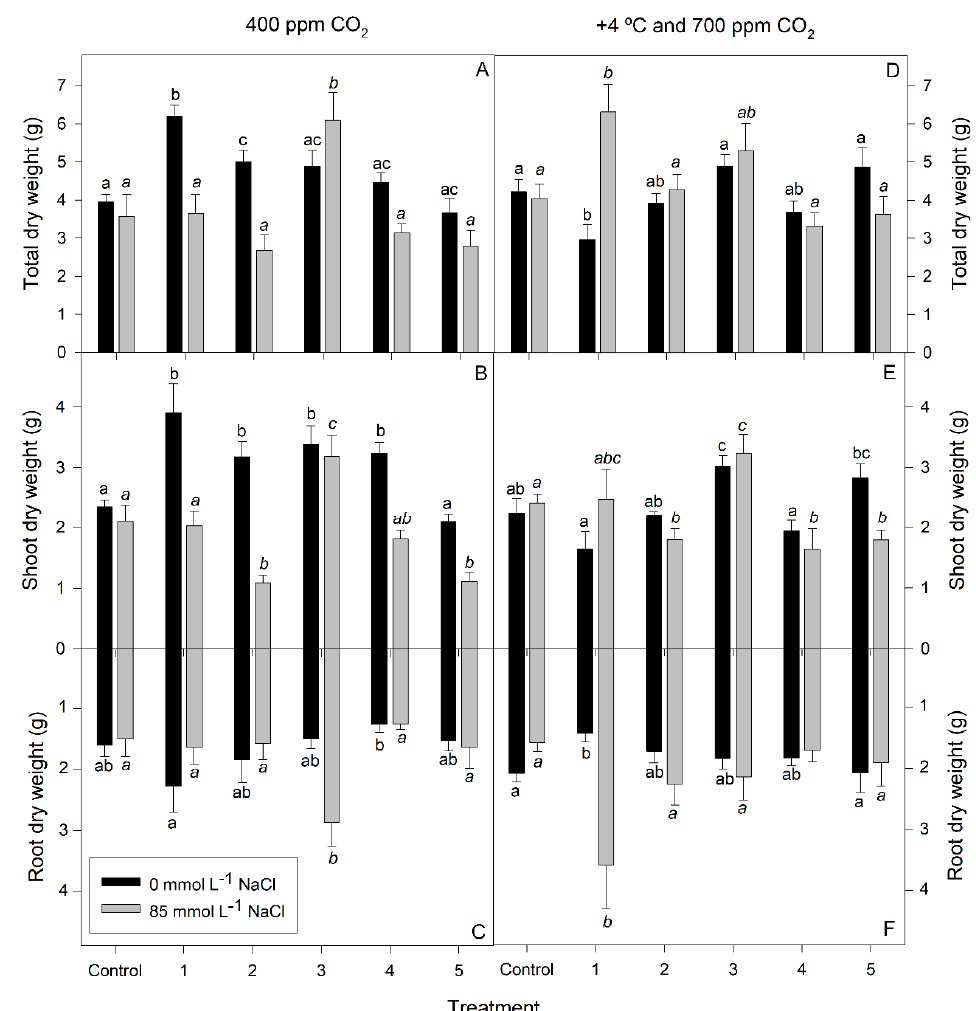
Figure 1. Total ( A , D ), shoot ( B , E ) and root ( C , F ) dry weights of strawberry plants inoculated with rhizobacteria consortia, numbered 1 to 5 (control = non-inoculated plants), after 30 d of treatment at 400 ppm CO 2 ( A – C ) and at +4 °C and 700 ppm CO 2 ( D – F ), with 0 and 85 mmol L − 1 NaCl. Each value represents the mean of ten replicates ± SE. Different letters for each saline treatment (capital and italic letters for 0 and 85 mmol L − 1 NaCl, respectively) indicate those means that are significantly different from each other (GLM; Duncan test, p < 0.05).